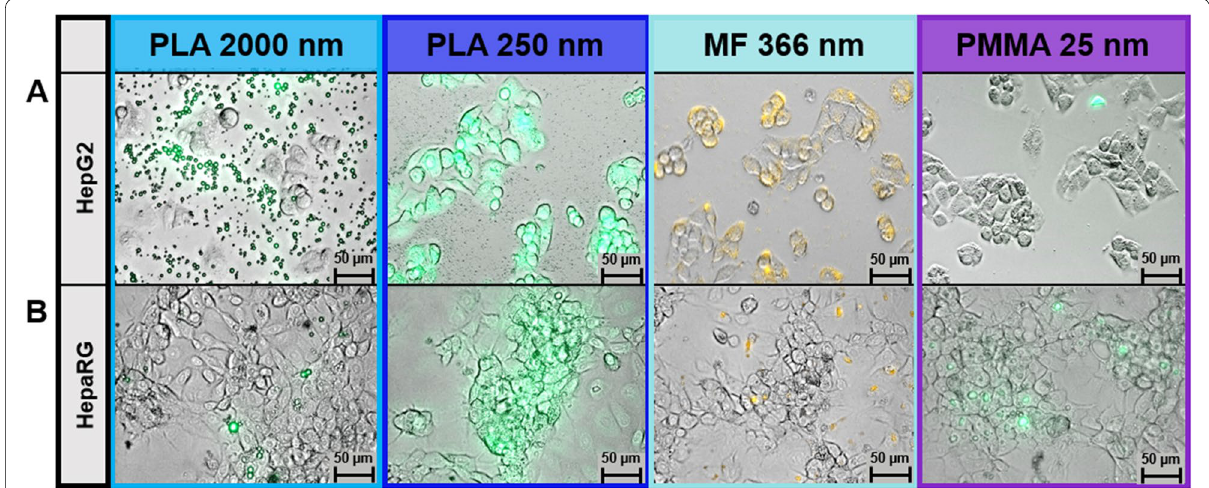
Fig. 4 Representative fluorescence microscopic images of particles after 24 h incubation with A : HepG2 and B : HepaRG cells. Gray structures indicate the cells and colored structures the